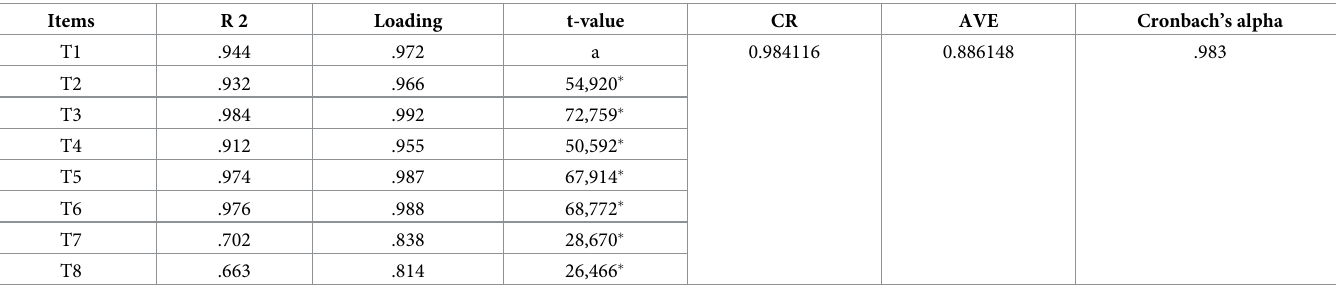
Table 8. The reliability statistics for the trust scale (obtained from confirmatory factor analysis).